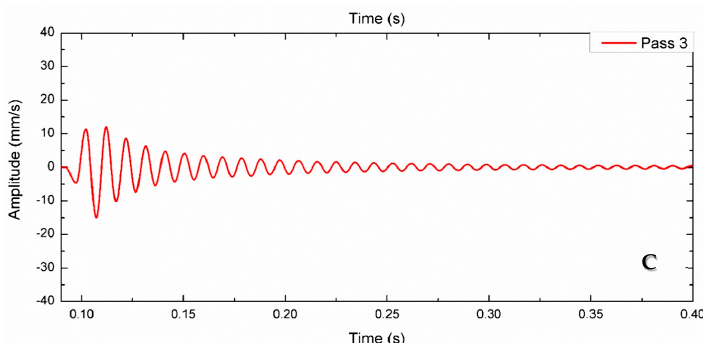
Figure 13. Effect of FSP multi-pass on damping capacity using the time decay stack curve at a tool rotation speed of 1400 rpm and a feed rate of 10 mm/min: ( A ) as received alloy; ( B ) Second pass FSP; ( C ) Third pass FSP.